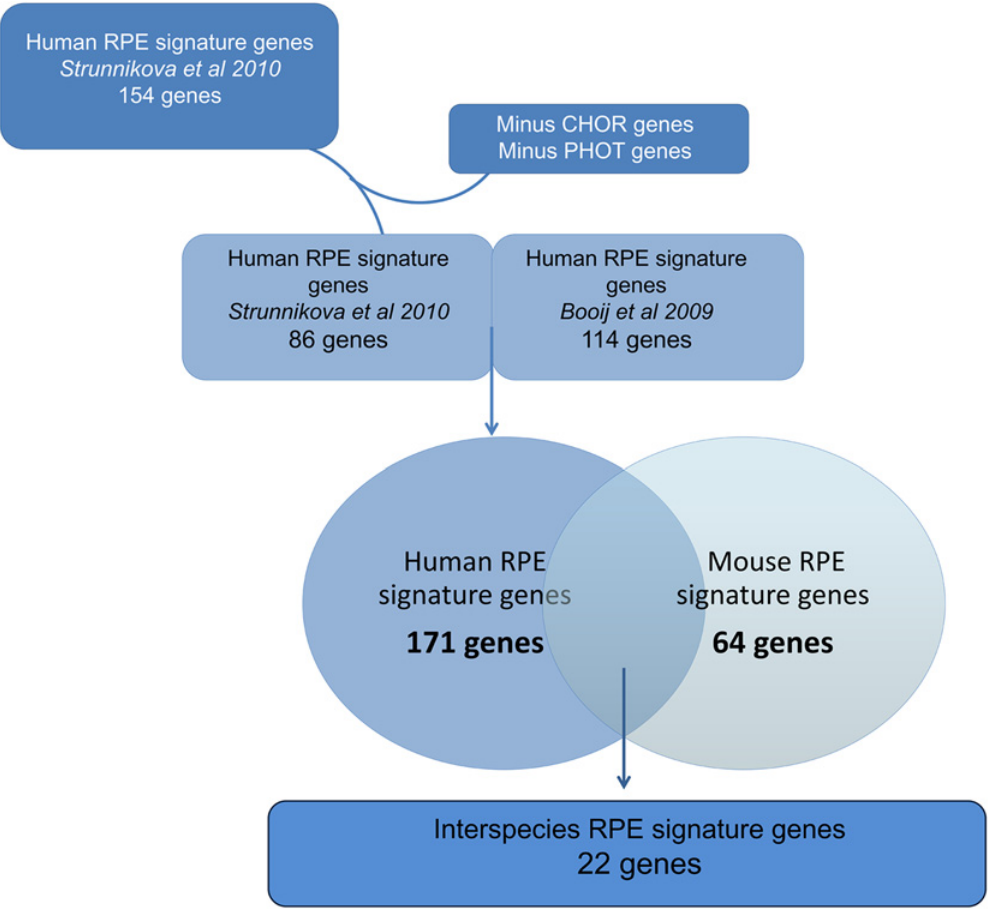
Fig 3. Strategy to determine “ Interspecies RPE signature genes ” . Schematic overview of our comparison strategy: our “ Mouse RPE signature genes ” dataset and “ Human RPE signature genes ” dataset, which contains (a modification of) two human RPE transcriptome datasets [12,15]. This resulted in a new dataset, “ Interspecies RPE signature genes ”